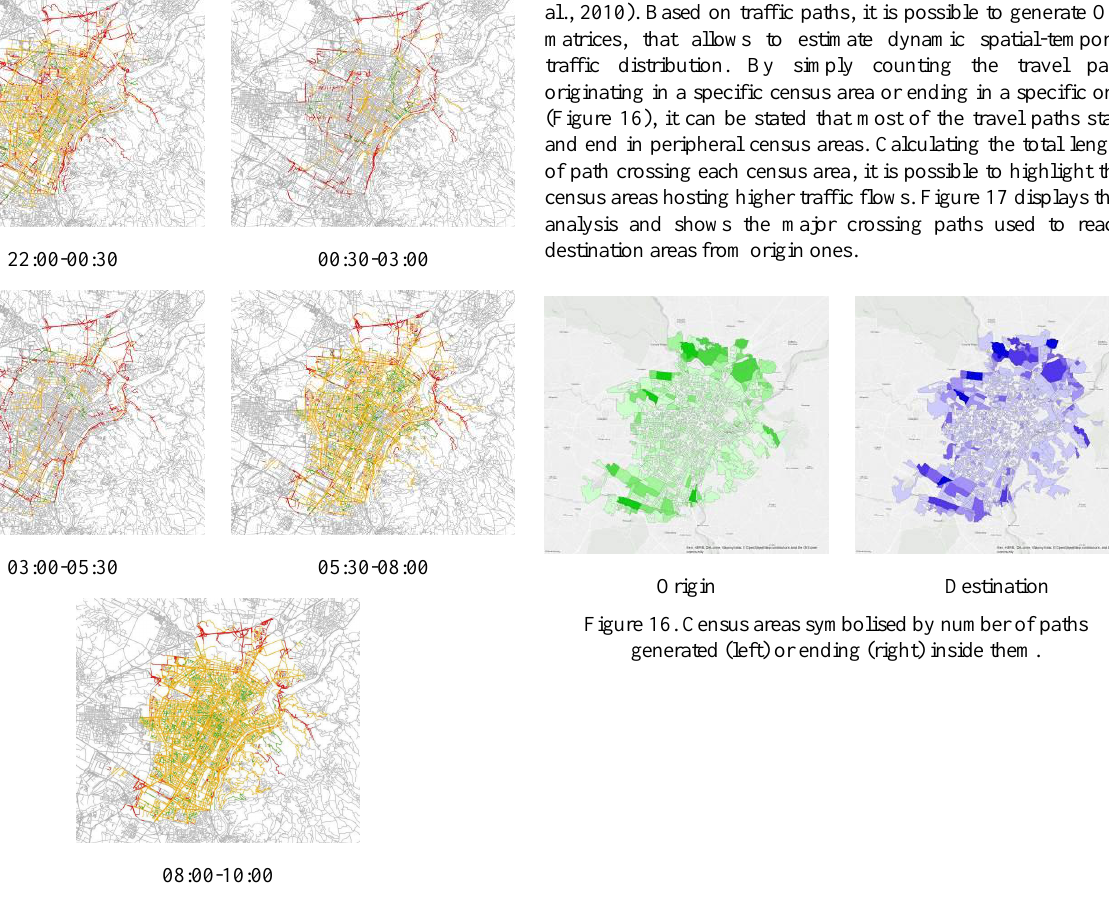
Figure 14. Mean travel speed in the different time slots.